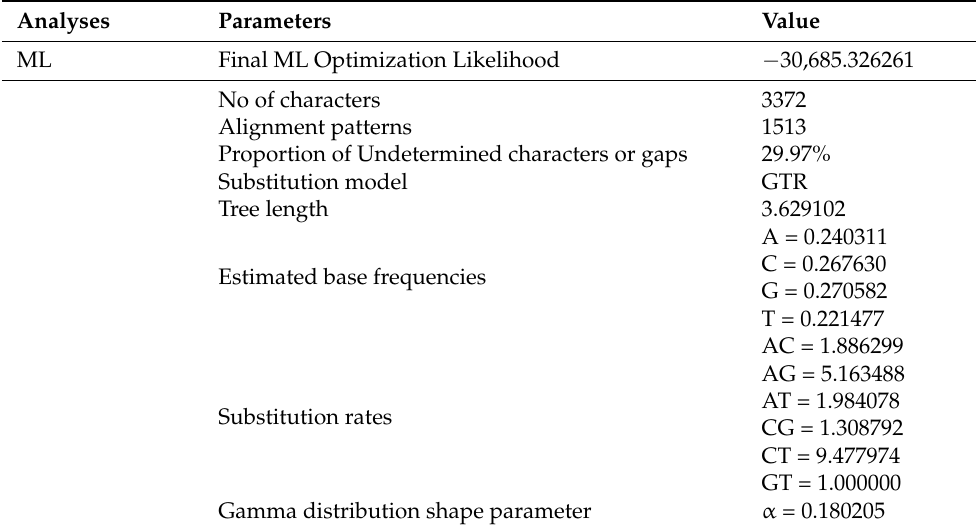
Table 4. Different parameters for ML